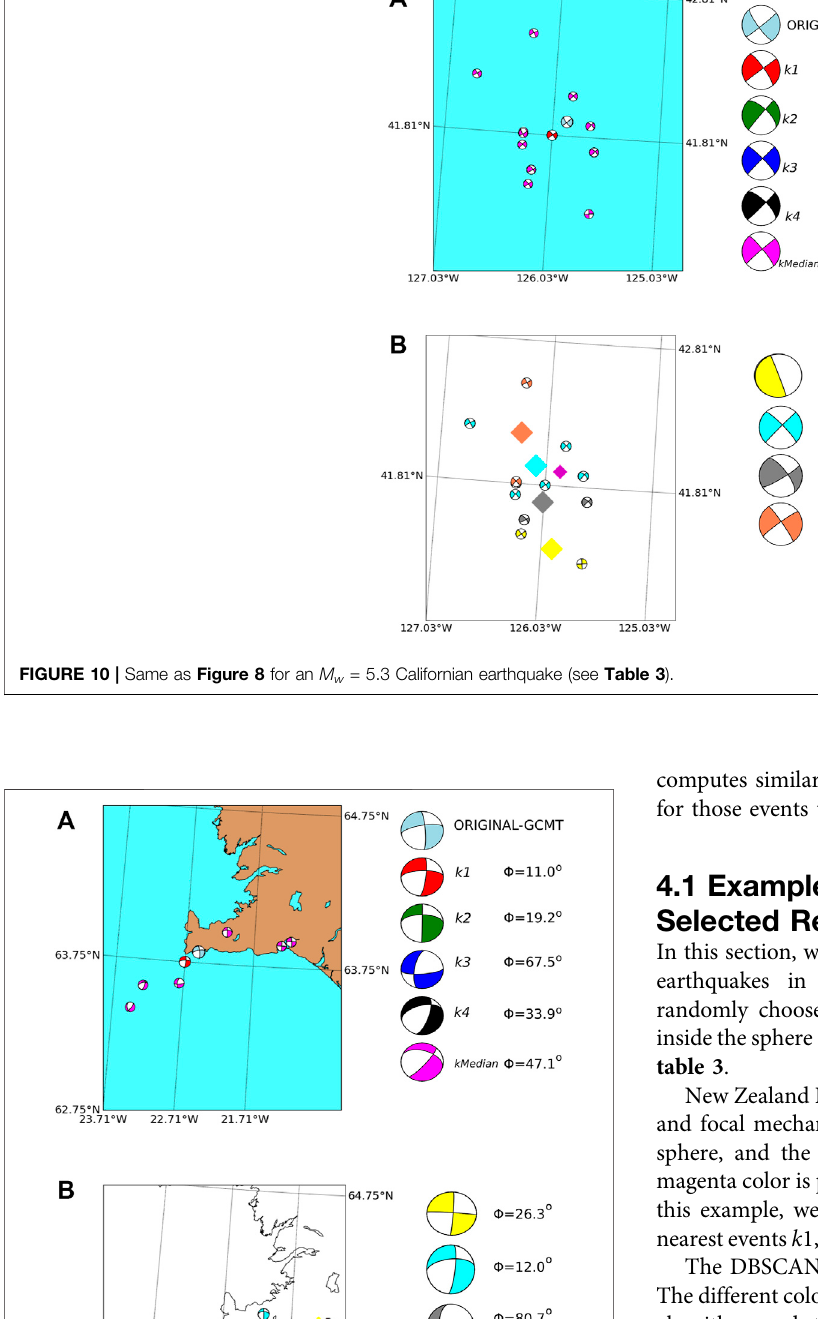
Frontiers in Earth Science |